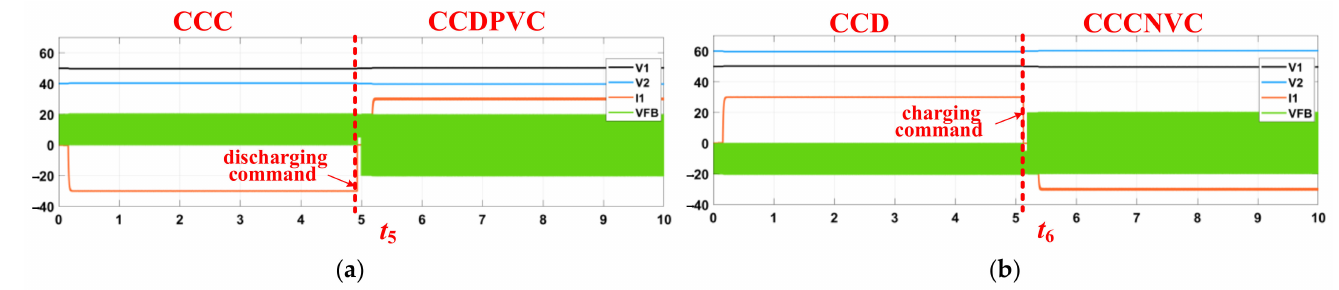
Figure 11. Waveforms in discharging and charging transitions: ( a ) charging to discharging; and ( b ) discharging to charging.